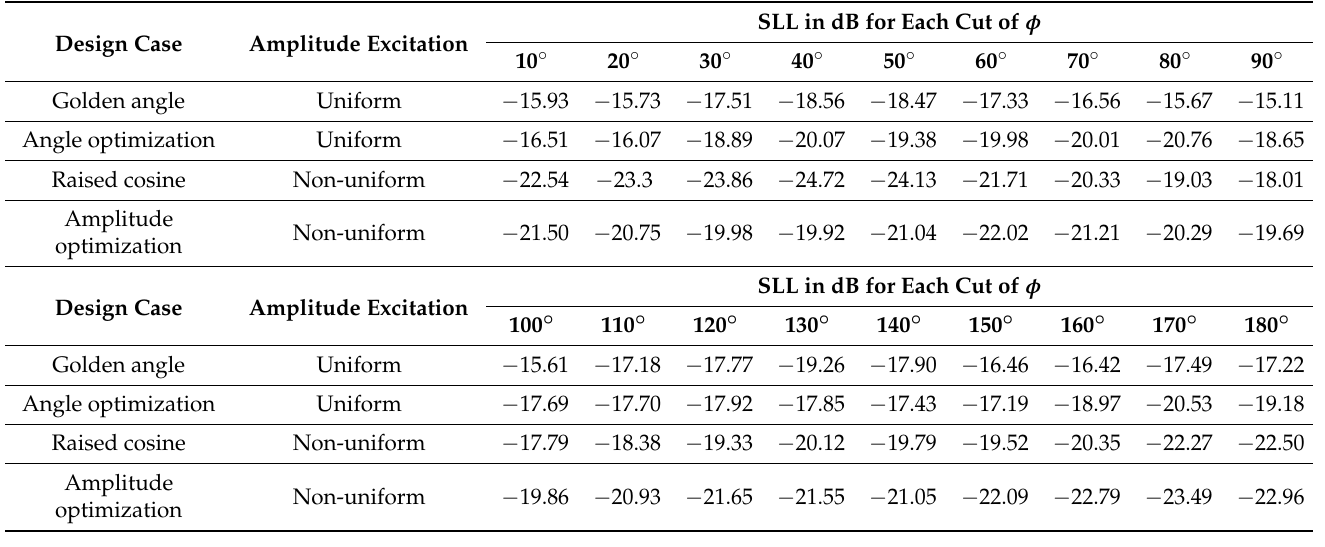
Table 4. Gain values obtained by the electromagnetic simulation for each proposed design case of the Fermat spiral